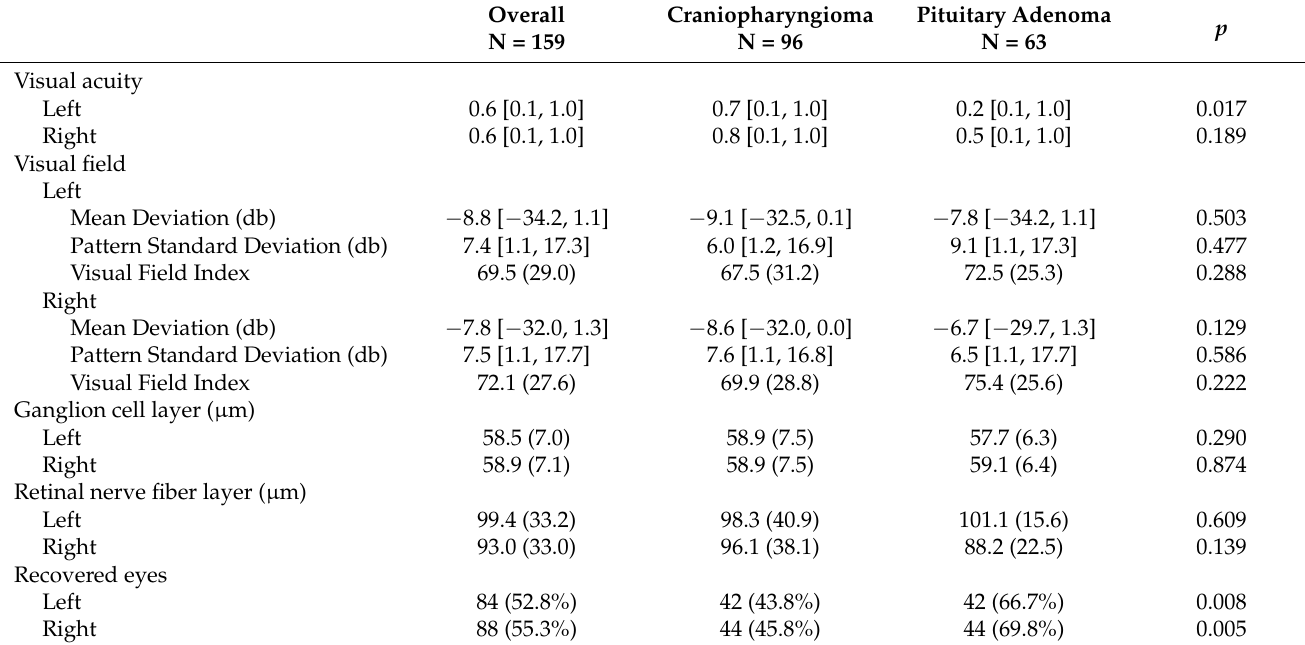
Table 2. Ophthalmic examinations in patients with different diagnoses and different eyes.